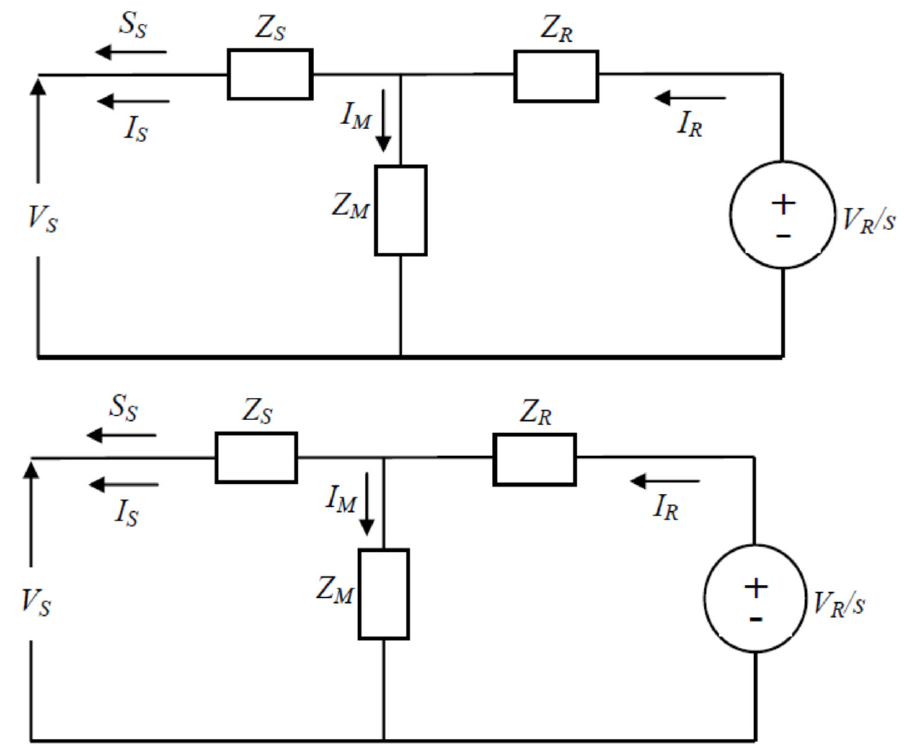
Figure 3. Equivalent circuits of WRIG (in terms of impedances).